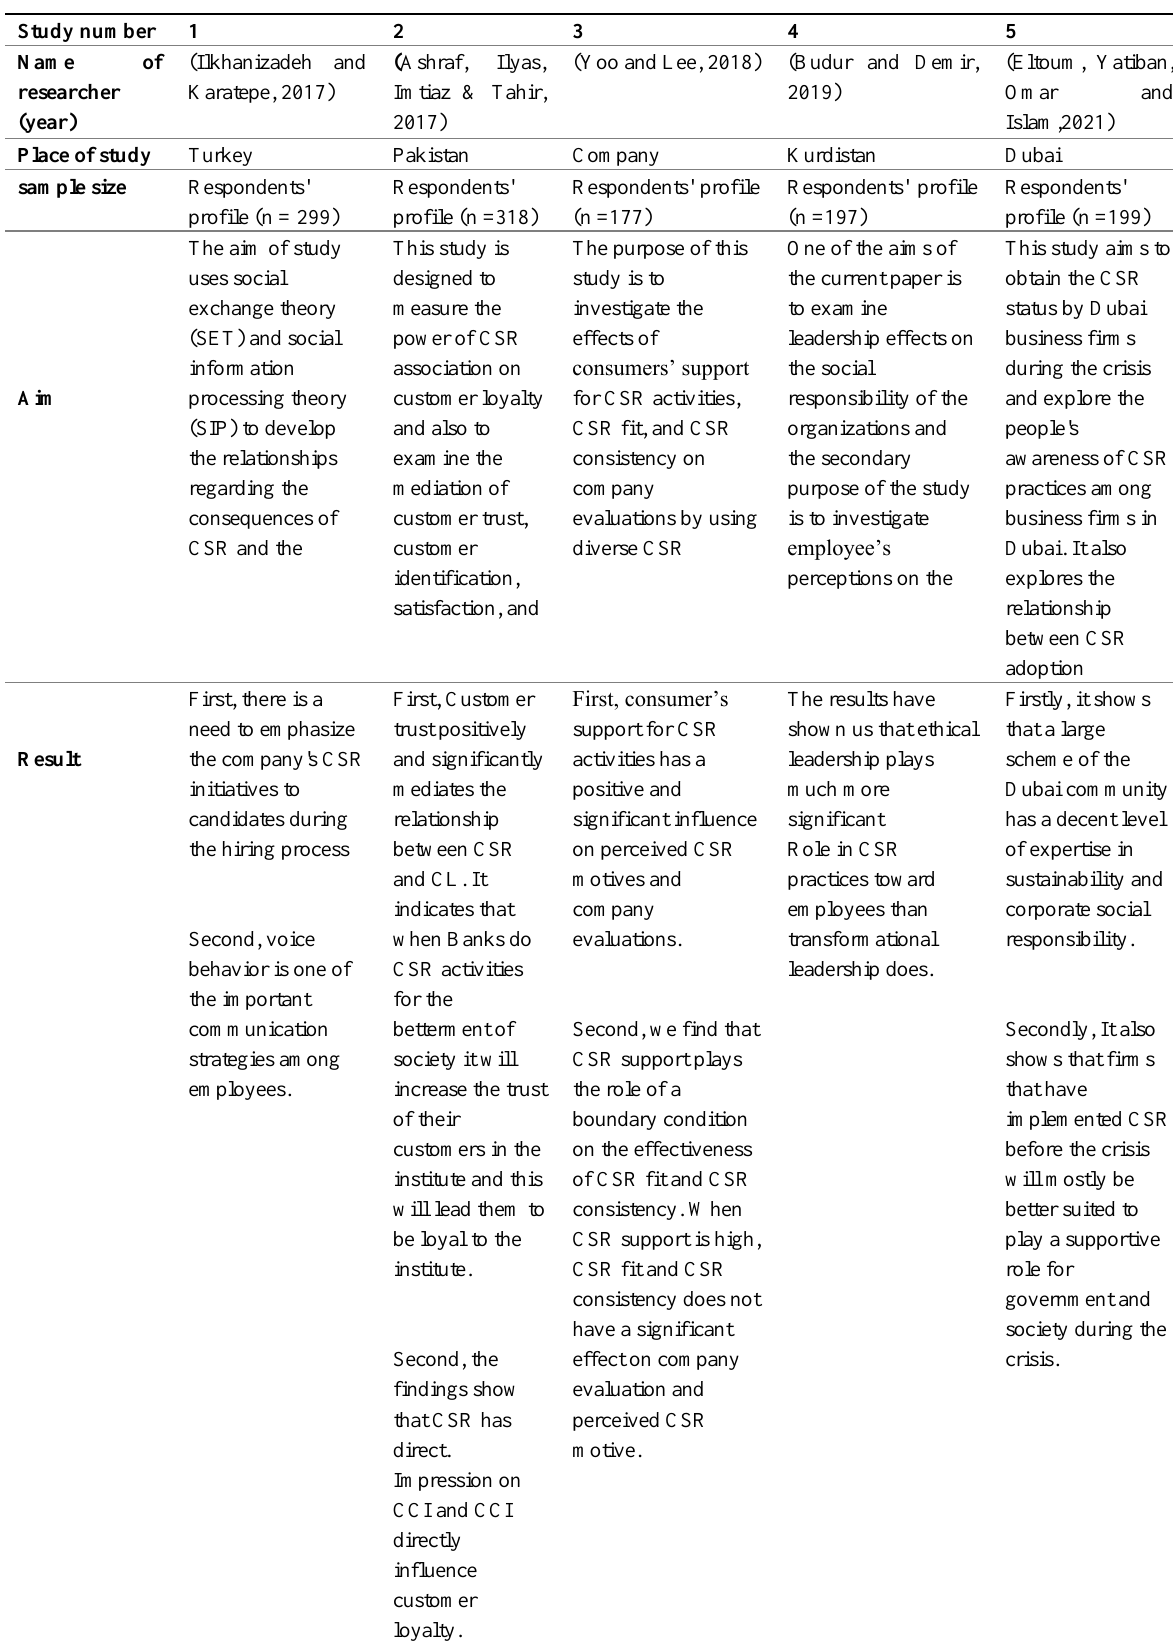
Table 1: Empirical studies for corporate social responsibility